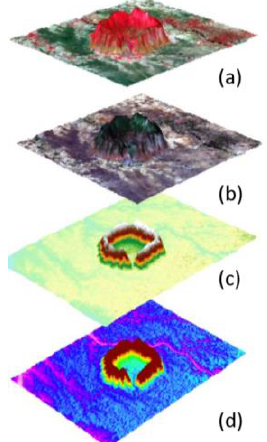
Figure 4. 3-D visualization of Ramgarh crater using SRTM DEM (a) DESIS FCC RGB floating on SRTM DEM (b) DESIS TCC RGB Floating on SRTM DEM (c) Cartosat-1 DEM